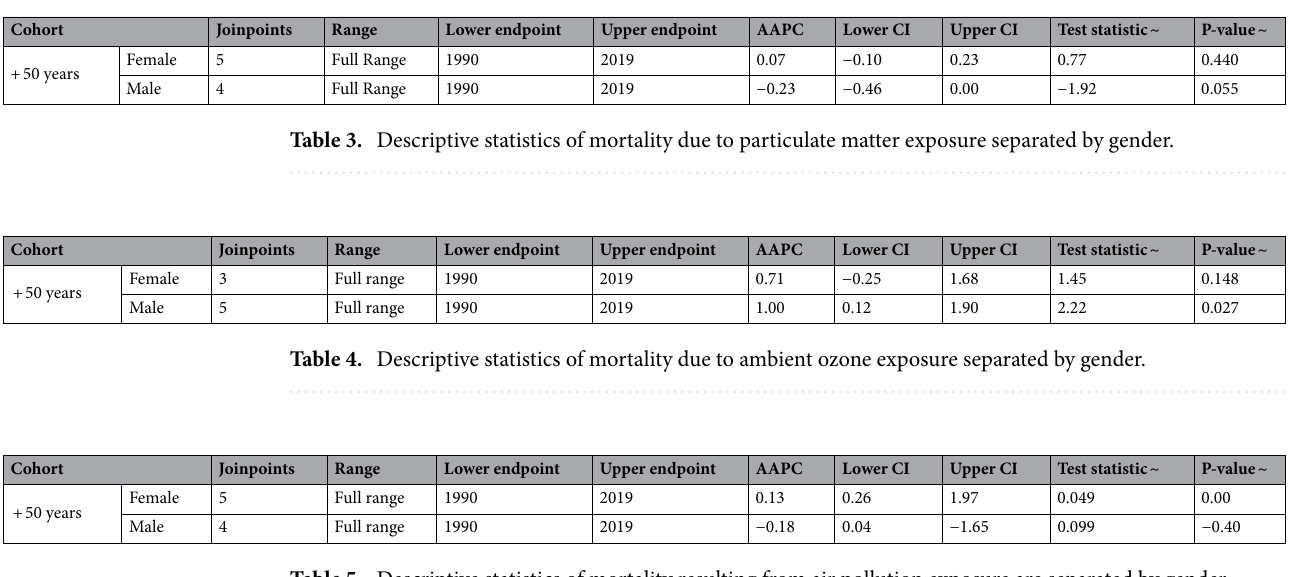
Table 5. Descriptive statistics of mortality resulting from air pollution exposure are separated by